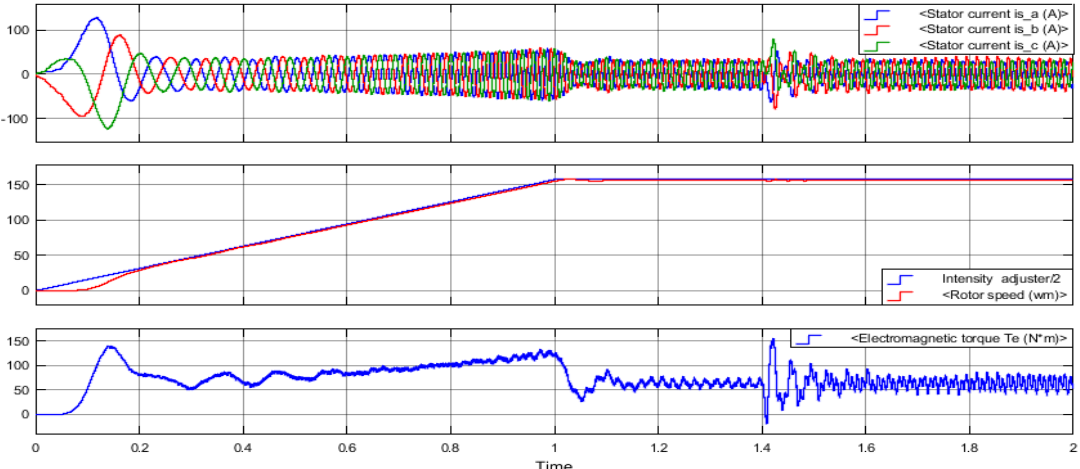
Figure 2. Oscillograms for the output coordinates of the electric motor.